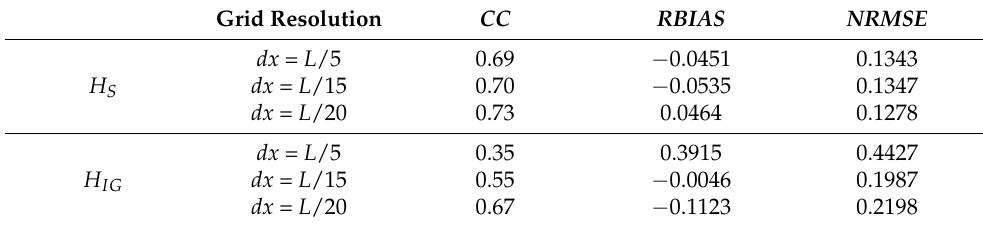
Table A3. Performance statistics of XB-SB at the location of sensor